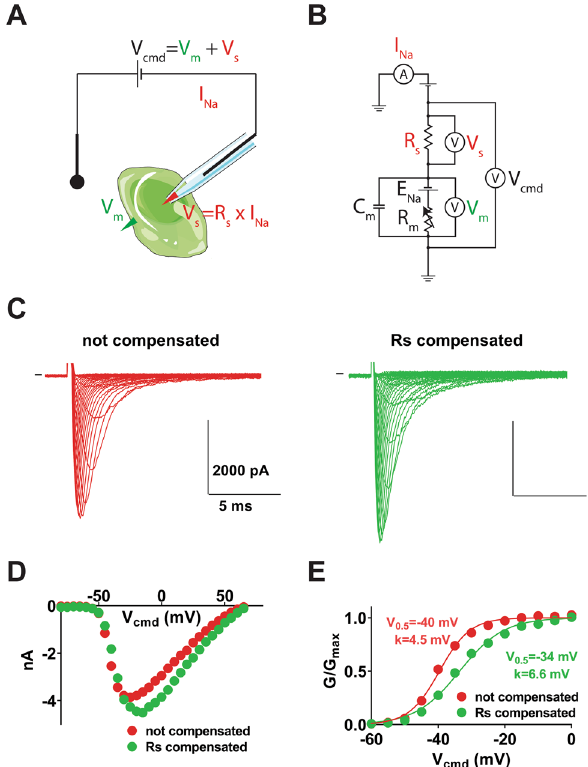
Figure 1. (A) Simplified scheme of a cell studied in voltage-clamp , illustrating how the potential clamped between the two electrodes is split between the membrane potential and a potential generated at the pipette tip. ( B) Scheme of the equivalent electrical circuit. Pipette capacitance and leak current due to imperfect seal between the pipette and the cell have been omitted for the sake of clarity. R m : cell resistance for Na + . This value depends on the Na + channel expression level and the fraction of expressed Na + channels that are open (the higher the value, the less active are the Na + channels). The fraction of channels in the open state depends on voltage and time. E Na : value of the reversal potential for Na + (determined by intra- and extracellular Na + concentrations according to the Nernst equation); Cm: cell capacitance (the higher the value, the larger is the cell). ( C ) Left, representative, superimposed recordings of heterologously-expressed Na v 1.5 during an activation voltage protocol (from HP = − 100 mV depolarization to steps from − 80 to + 65 mV), with no compensation. Right, recordings of the same cell with R S compensation. ( D ) I/V curves in the two conditions presented in (C) . ( E ) Activation curves in the two conditions presented in (C)